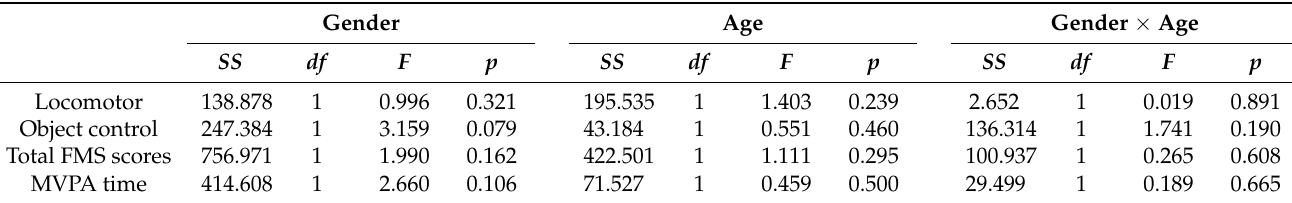
Table 4. MANOVA of FMS and MVPA by gender and age. Gender Age Gender × Age